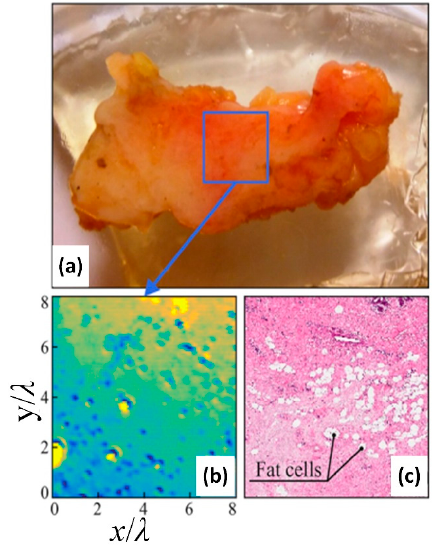
Figure 13. THz solid immersion microscopy of soft biological tissues with the spatial resolution of 0.15 λ : ( a ) Photo of an ex vivo human breast tissue specimen; ( b ) THz SI microscopy image of human breast tissue; ( c ) The diagnosis of the breast tissue specimen as confirmed by histology